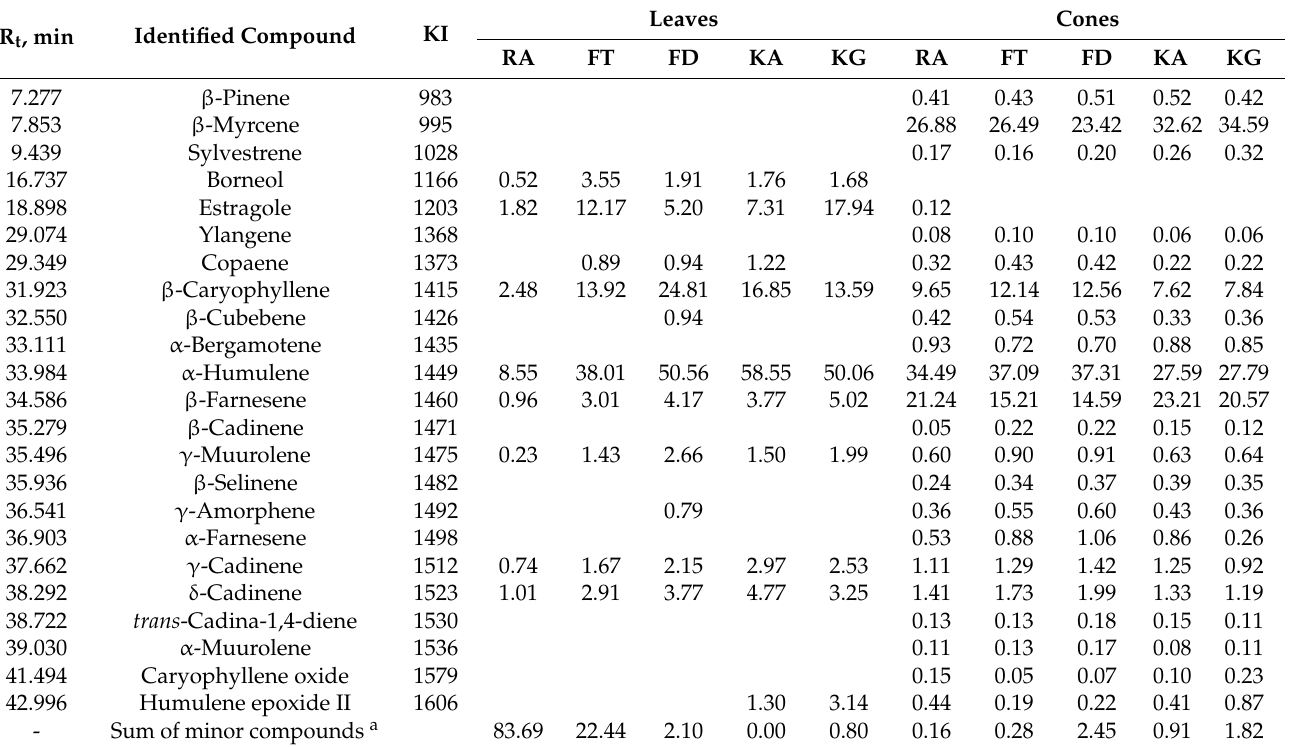
Table 2. Main volatile compounds and their percentage composition in the supercritical fluid extract of leaves and cones of analyzed Lithuanian hop varieties (Rt—average retention time of